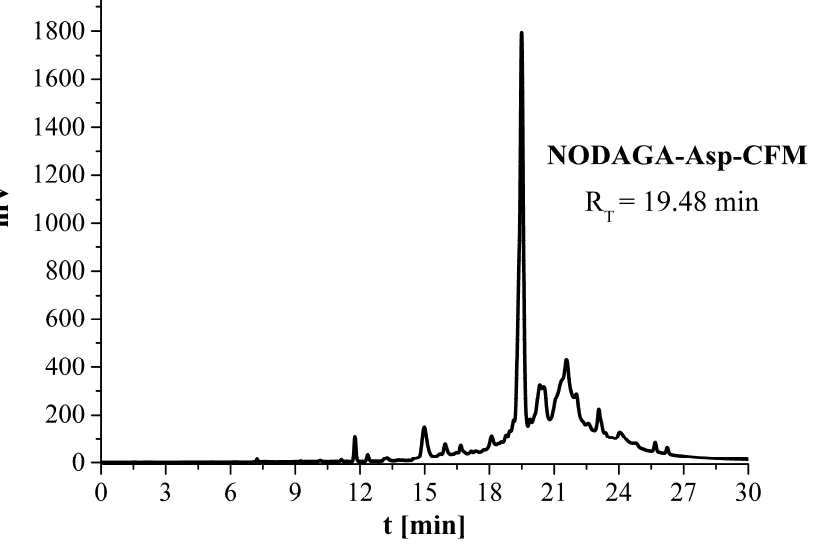
Figure 4. HPLC chromatogram (at 270 nm) of the reaction mixture of NODAGA-Asp-CFM (R T = 19.48 min) conjugate synthesis (gradient 2).